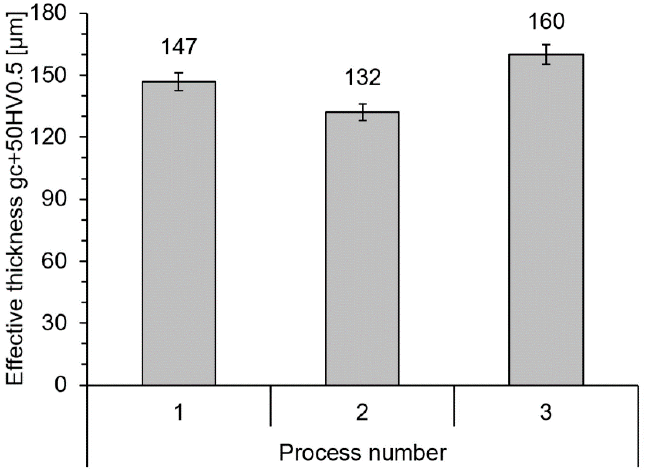
Figure 4. Results of effective thickness (diffusion zone thickness) analysis of X37CrMoV5 ‐ 1 steel after low ‐ pressure nitriding processes.